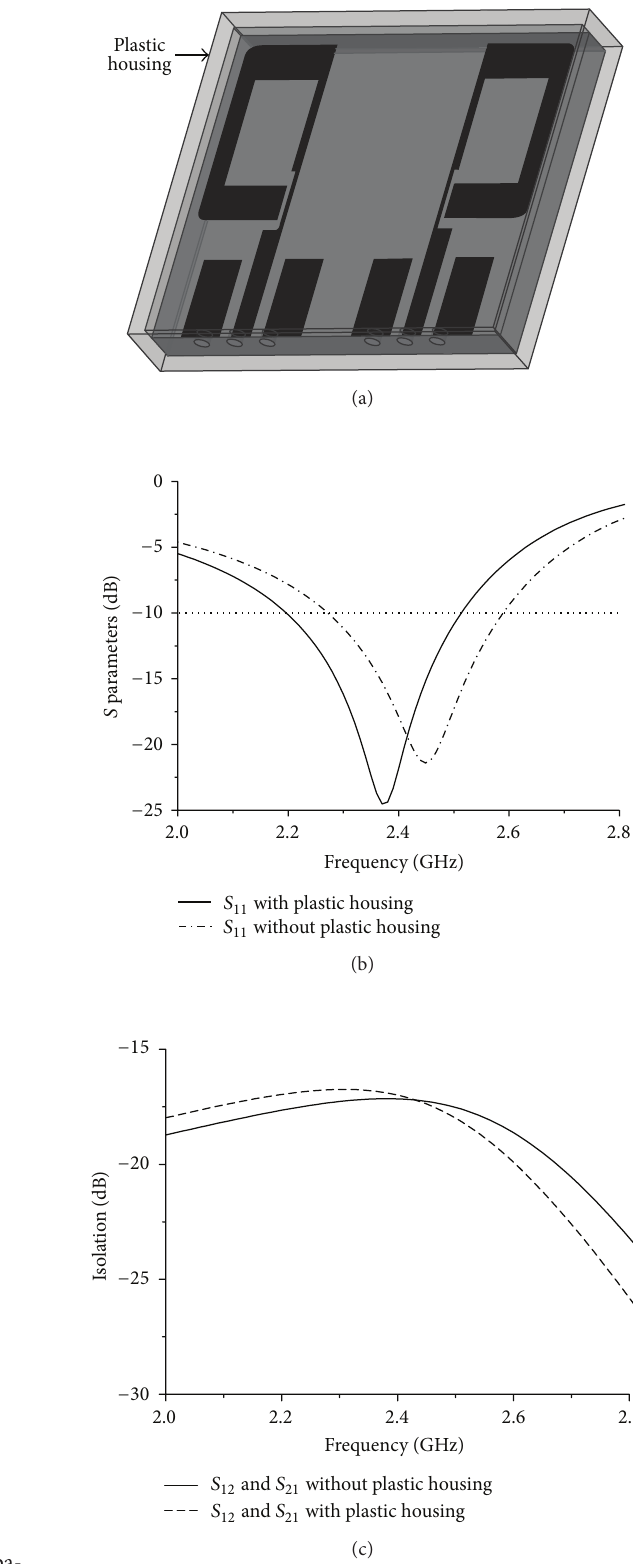
Figure 16: (a) Proposed antenna with plastic housing. (b) Reflection coefficients. (c)